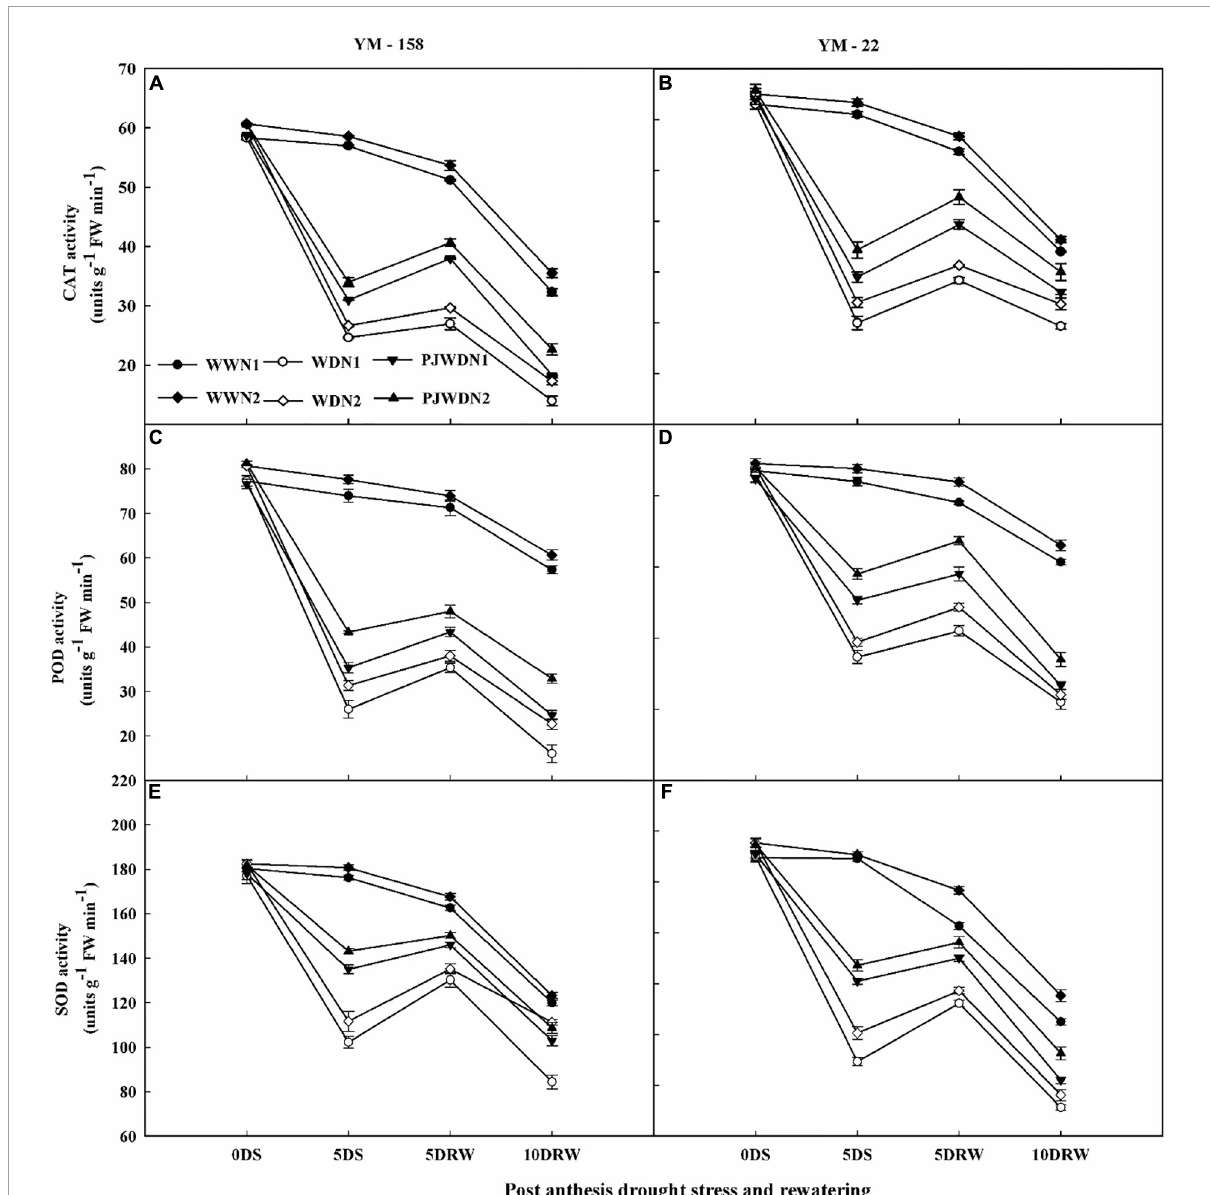
FIGURE7 Effects of pre-drought priming on catalase (CAT), peroxidase (POD), and superoxide dismutase (SOD) content in response to post-anthesis drought stress under two nitrogen (N) rates (N1, 180 and N2, 300) in Yangmai-158 (A,C,E) and Yangmai-22 (B,D,F) wheat cultivars. Treatments: WW (control), no priming at jointing + no post-anthesis drought stress; PJWD, priming at jointing + post-anthesis drought stress; and WD, no priming at jointing + post-anthesis drought stress. Pre-drought priming was completed during the jointing stage, and post-anthesis drought stress was applied from 7 to 14 days after anthesis. The horizontal axis shows the time course of the sampling: 1 day before drought stress (0DS), 5 days after drought stress (5DS), and 5 and 10 days after re-watering (5DRW and 10DRW). Each vertical bar above the mean value indicates the standard error of three replicates ( n = 3) by using three-way ANOVA at P < 0.05.